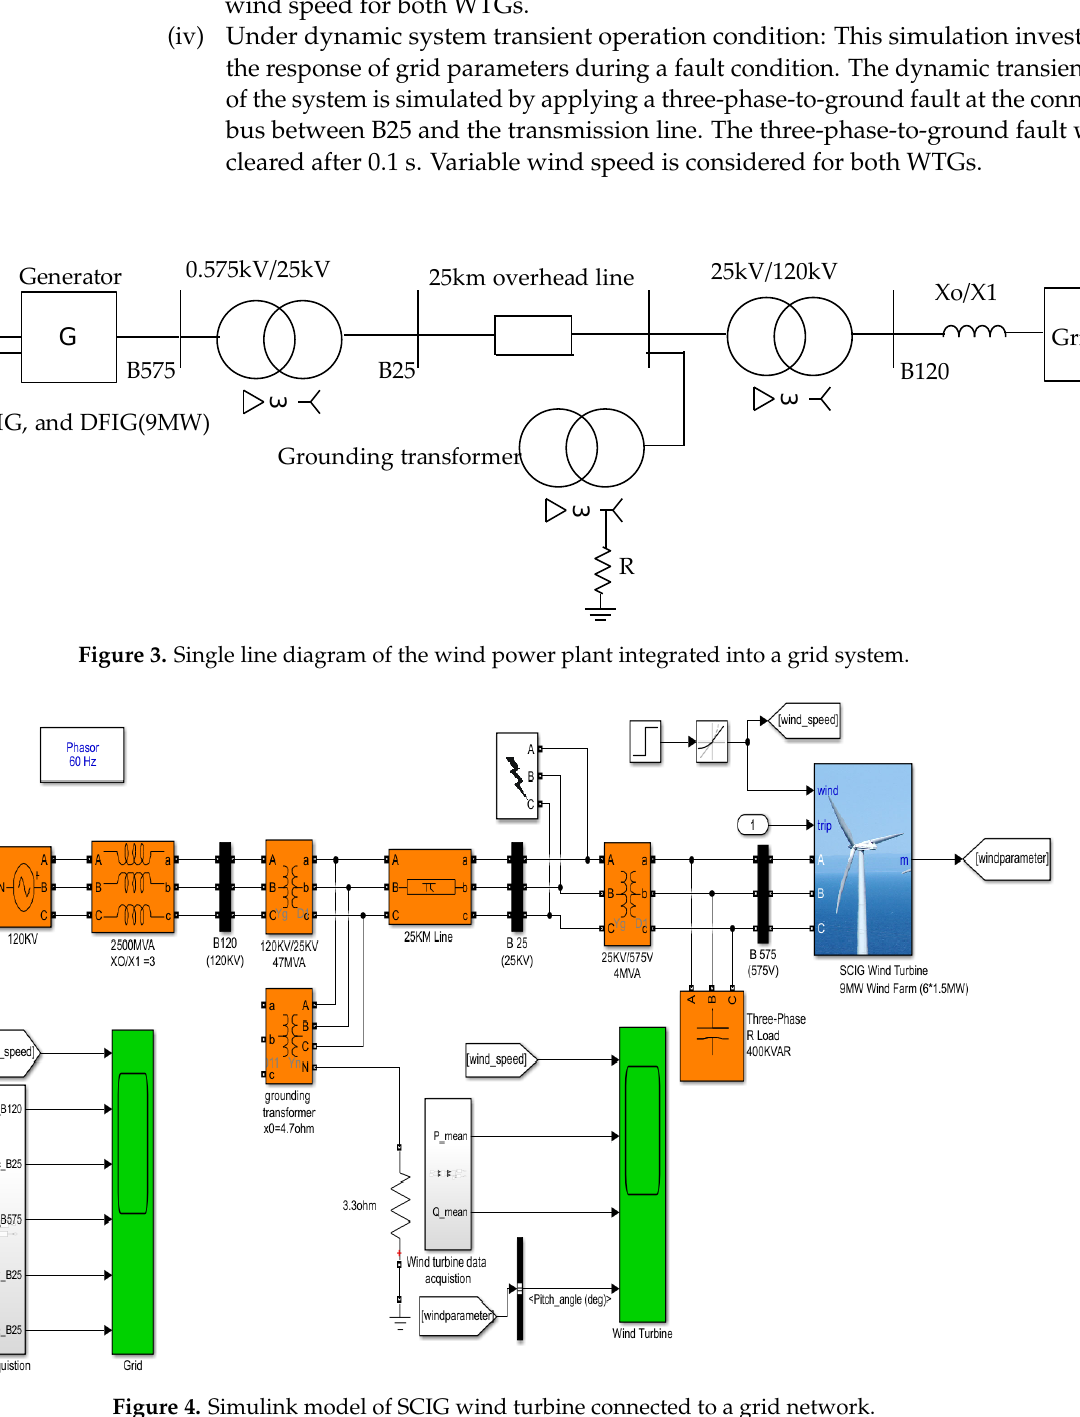
Figure 5 . Detail model for SCIG wind turbine and generator under the mask. Table 1 . Network parameter values for simulated SCIG and DFIG. Equipment Parameter